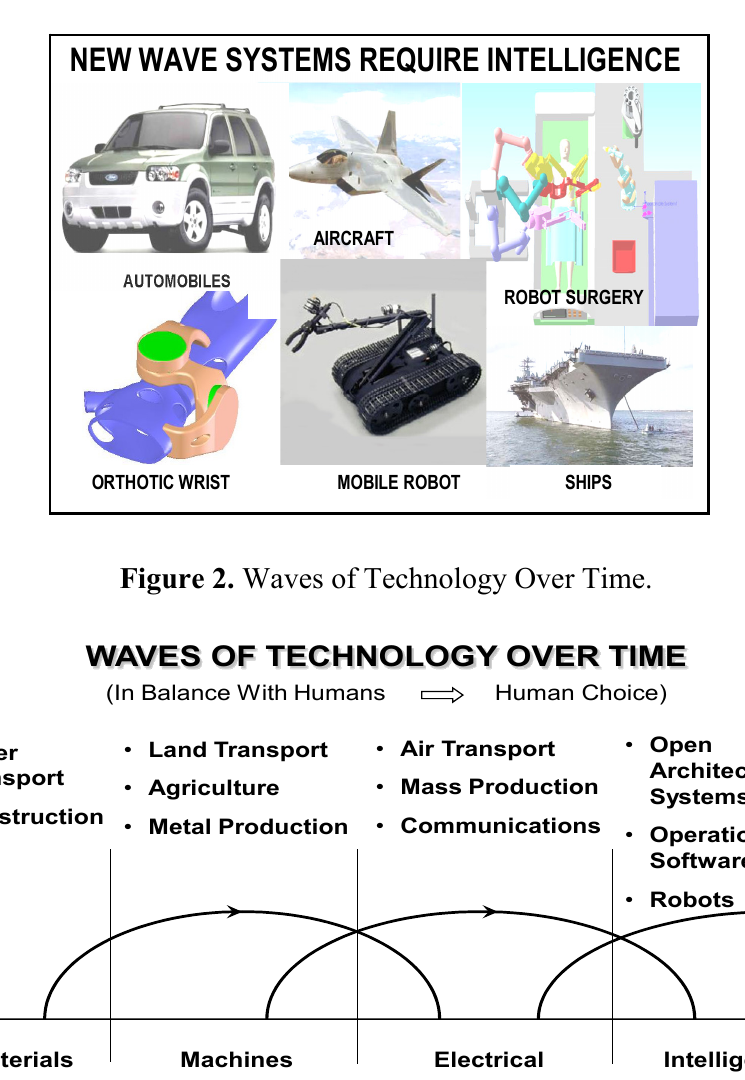
Figure 1. Representative Next Wave of Technology (NWT) Open Architecture Systems Driven by Intelligent Actuators.